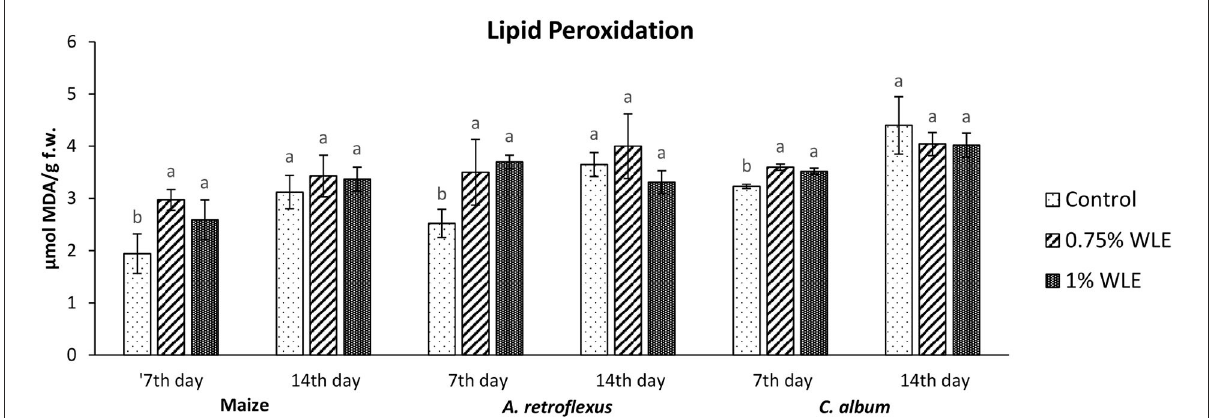
FIGURE2 Lipid peroxidation in maize and weeds - Amaranthus retroflexus and Chenopodium album as a response to treatment with 0.75 and 1% walnut leaf extract, on 7 th and 14 th day after treatment. Data are presented as mean ± SD. Values marked with different letters within a group differ significantly based on Tukey’s HSD test ( p ≤ 0.05).